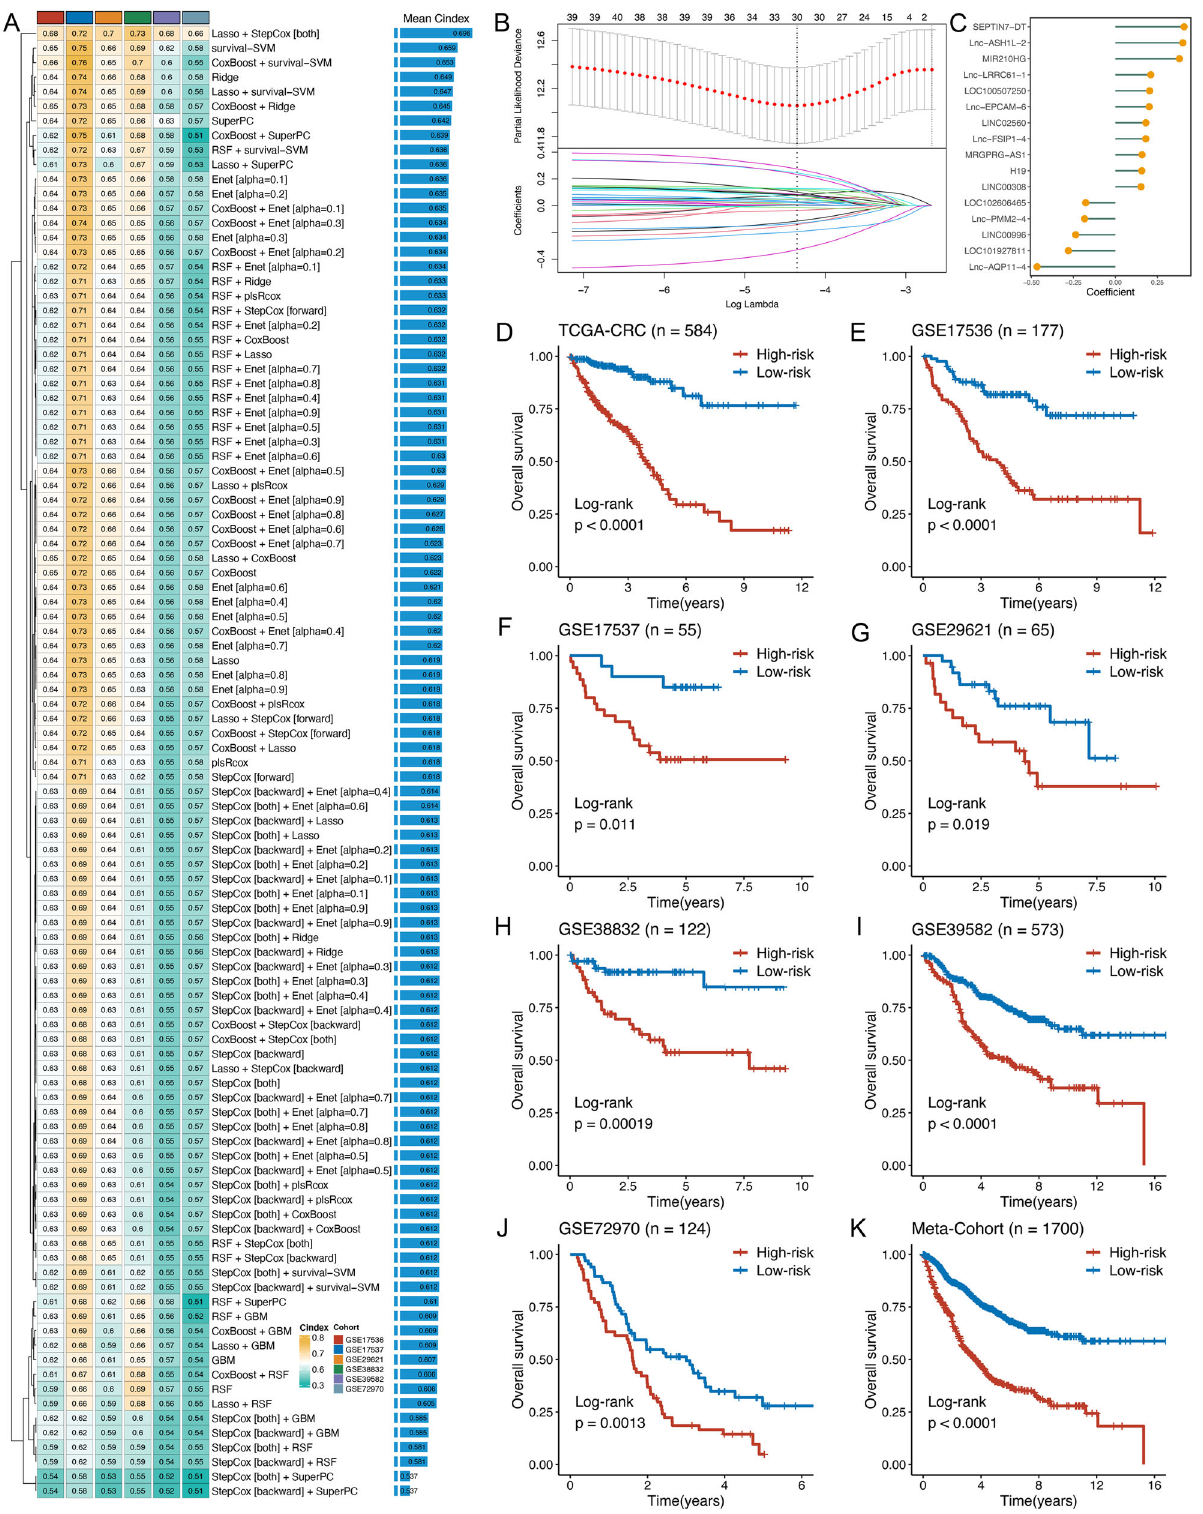
Fig. 2 A consensus IRLS was developed and validated via the machine learning-based integrative procedure. A A total of 101 kinds of prediction models via LOOCV framework and further calculated the C-index of each model across all validation datasets. B In the TCGA-CRC cohort ( n = 584), the determination of the optimal λ was obtained when the partial likelihood deviance reached the minimum value, and further generated Lasso coef fi cients of the most useful prognostic genes. Data are presented as mean ± 95% con fi dence interval [CI]. C Coef fi cients of 16 lncRNAs fi nally obtained in stepwise Cox regression. D – K Kaplan – Meier curves of OS according to the IRLS in TCGA-CRC (log-rank test: P = 9.16e − 19) ( D ), GSE17536 (log-rank test: P = 2.79e − 7) ( E ), GSE17537 (log-rank test: P = 0.011) ( F ), GSE29621 (log-rank test: P = 0.019) ( G ), GSE38832 (log-rank test: P = 1.87e − 4) ( H ), GSE39582 (log- rank test: P = 2.06e − 10) ( I ), GSE72970 (log-rank test: P = 0.0013) ( J ), and meta-cohort (log-rank test: P = 5.18e − 35) ( K